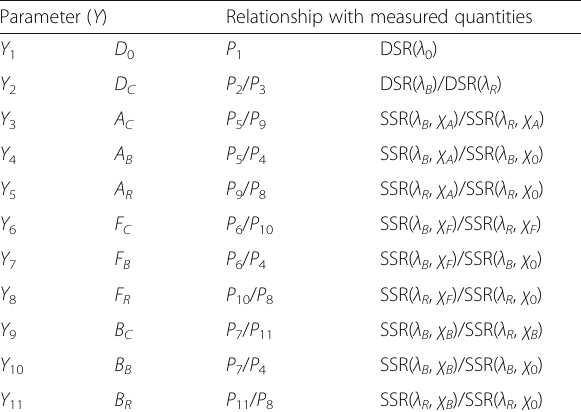
retrieval Parameter ( Y ) Relationship with measured quantities